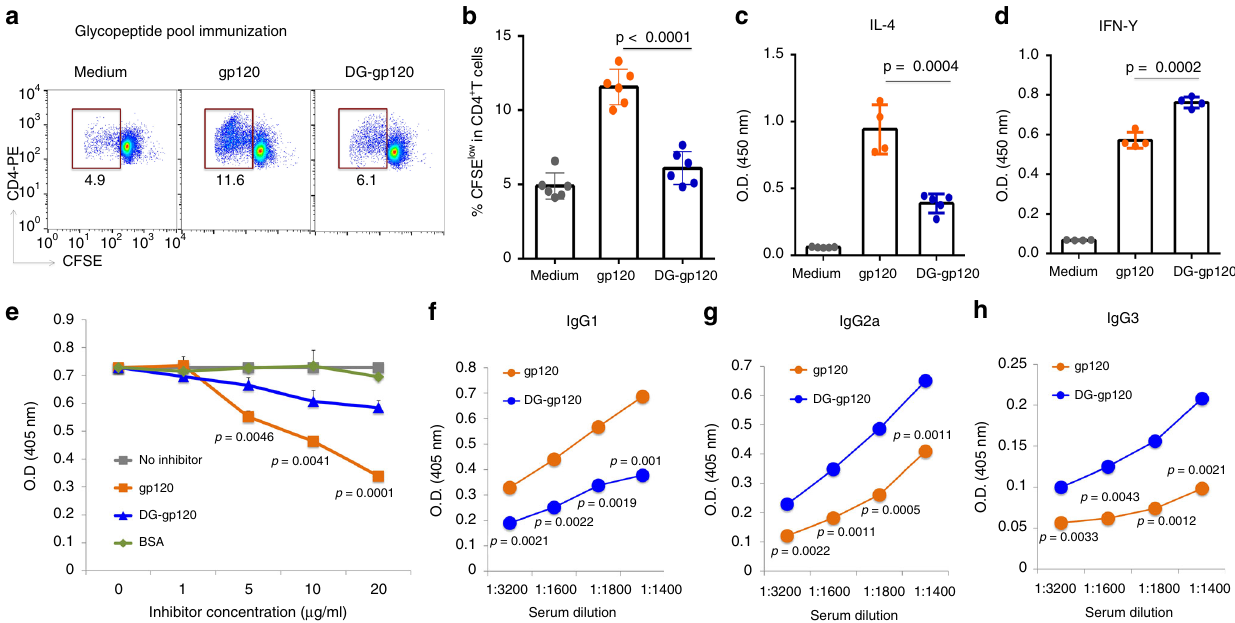
Fig. 1 gp120 glycopeptide epitopes are recognized by CD4 + T cells. BALB/c mice were immunized with pooled gp120 glycopeptides (prepared by protease digestion of gp120). After booster immunization, CD4 + T cells were isolated and stimulated in vitro with either intact gp120 or PNGase F – treated, deglycosylated gp120 (DG-gp120) in the presence of mitomycin C-treated APCs for 5 days. a , b Flow cytometric analysis of T cell proliferation by CFSE division among CD4 + T cells. c , d Production of IL-4 c and IFN- γ d in the culture supernatant after T cell stimulation was measured by ELISA. e Recognition of coated gp120 by antiserum from mice immunized with gp120 glycopeptides in the presence of the indicated inhibitors was examined by competition ELISA using a serum dilution 1:1600. Serum titers are reported as OD at 405 nm. f – h Serum from mice immunized with pooled gp120 glycopeptides were collected 7 days after booster immunization. Titers of IgG1 f , IgG2a g , and IgG3 h for recognition of glycosylated gp120 or deglycosylated gp120 were measured by ELISA. Representative results are shown from one of three independent experiments performed. (mean ± s.d.). b n = 6 independent experiments. c n = 5 for medium and DG-gp120; n = 4 for gp120. n = 4, 3, 2, 2, 2 independent experiments for d – h , respectively. P -values were